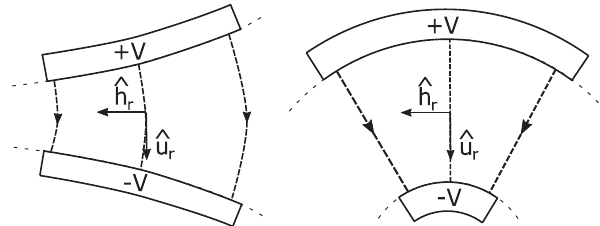
FIG. 5. Creating normal quadrupole field gradients by using hyperbolic electrodes (left), and creating skew quadrupole field gradients by using cylindrical electrodes (right). The left-hand method is similar to the angled electrodes used by Sumitomo and by C2, while the right-hand method is similar to the V-shaped Dubna design shown in Fig. 2.